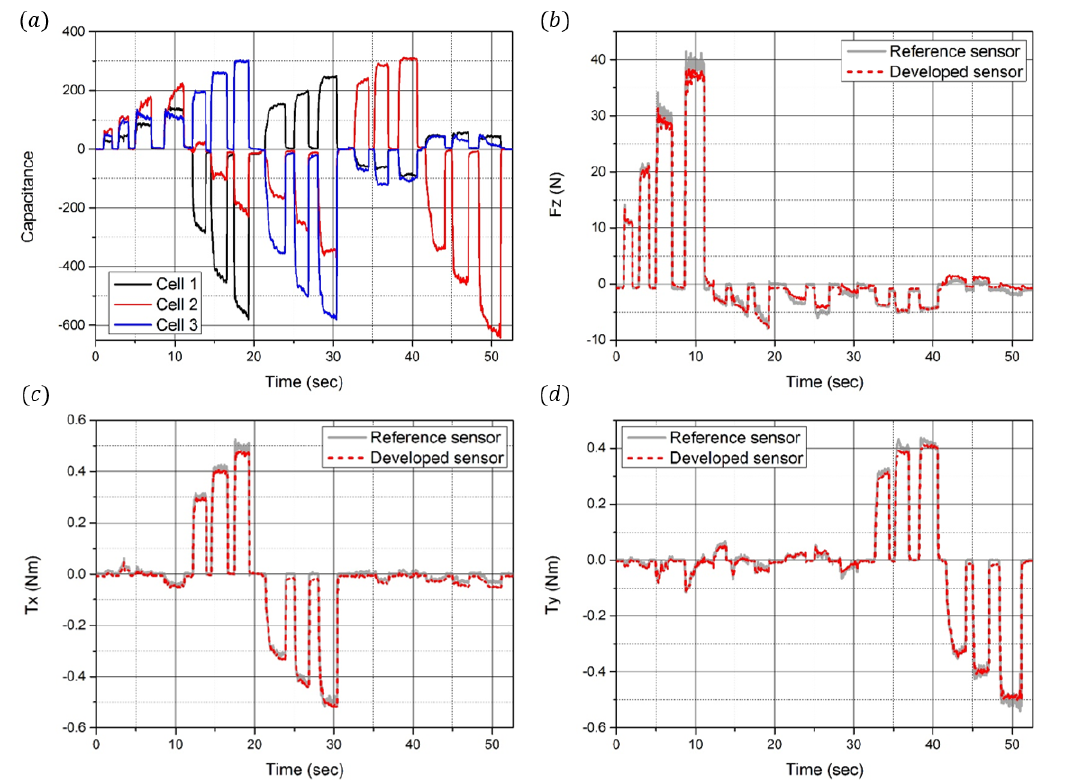
Figure 11. Calibration results. ( a ) Time domain responses of the capacitance change in the three sensing electrodes. ( b ) Time domain response of the z-direction force measured by the developed sensor (red dot) and the reference sensor (gray line). ( c ) Time domain response of the x-direction torque measured by the developed sensor and the reference sensor. ( d ) Time domain response of the y-direction torque measured by the developed sensor and the reference